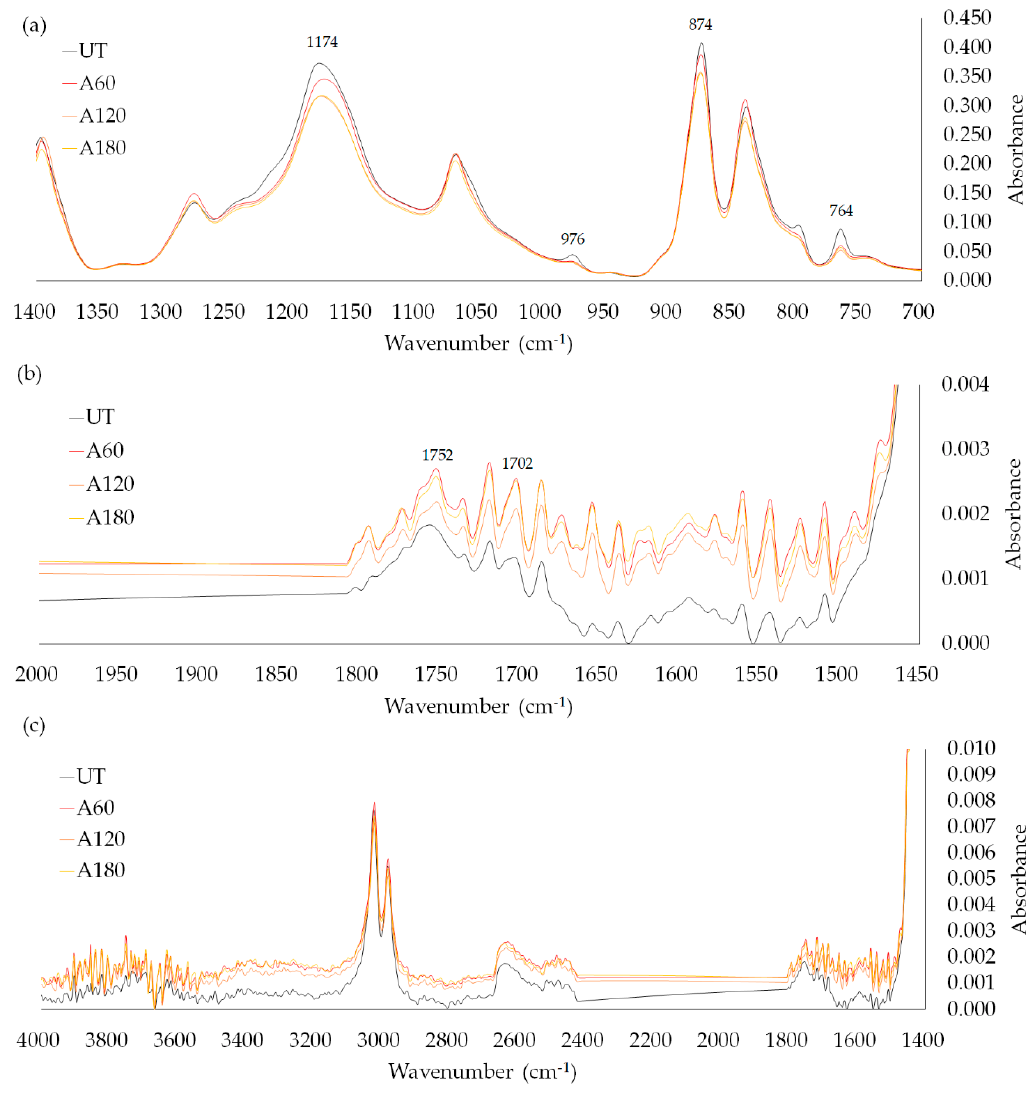
Figure A1. FT-IR spectra of PVDF films treated with an NaOH solution for 0 min (UT), 60 min (A60), 120 min (A120), and 180 min (A180) for the range of 700–1400 cm − 1 ( a ), 1450–2000 cm − 1 ( b ), 1400–4000 cm − 1 ( c ).